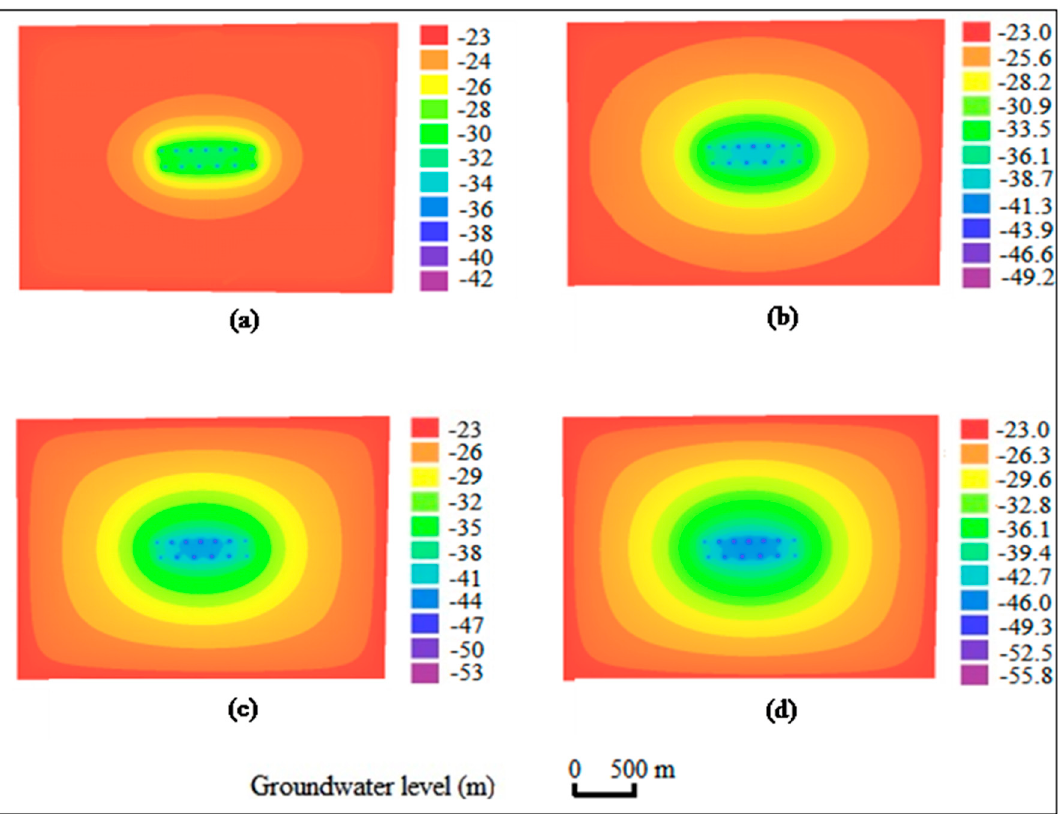
Figure 10. Contour maps of groundwater level in the third confined aquifer during pumping. ( a )